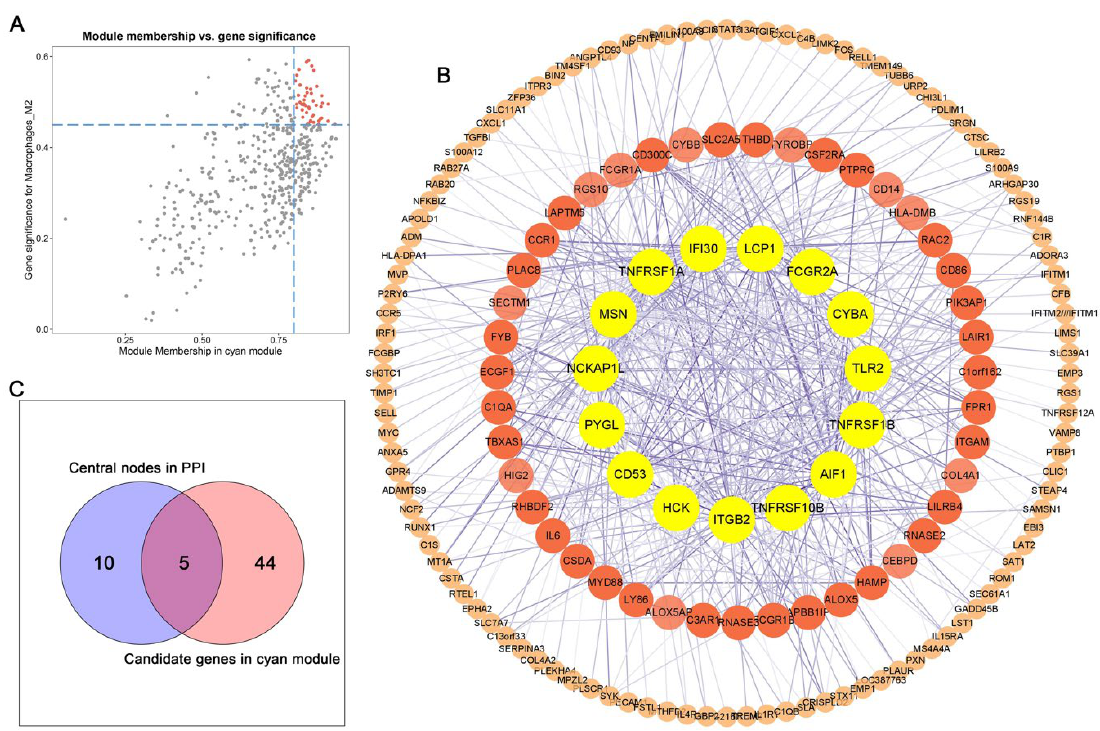
Figure 5. Identification of hub genes. ( A ) Scatter plot of the genes in the cyan module. Red dots indicate candidate genes of MM > 0.8 and GS > 0.45. ( B ) PPI network constructed from genes in the cyan module. Yellow nodes were selected as hub nodes (cut-offs of weight >0.15 and connectivity >15). ( C ) Venn diagram indicating five overlapped genes from hub nodes in PPI and candidate genes in cyan module.